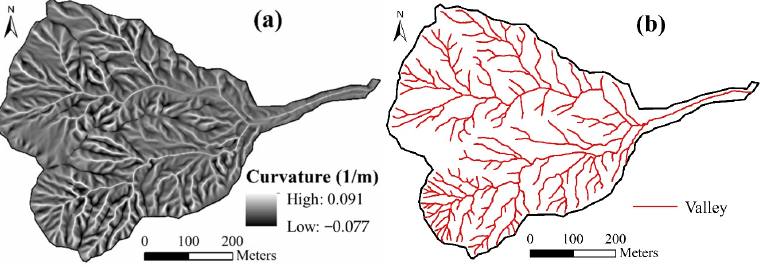
Figure 5. Curvature-based valley network extraction: ( a ) Contour curvature computed from the filtered DEM and ( b ) extracted valley network based on the curvature threshold in the Isleta Drain watershed located in New Mexico.